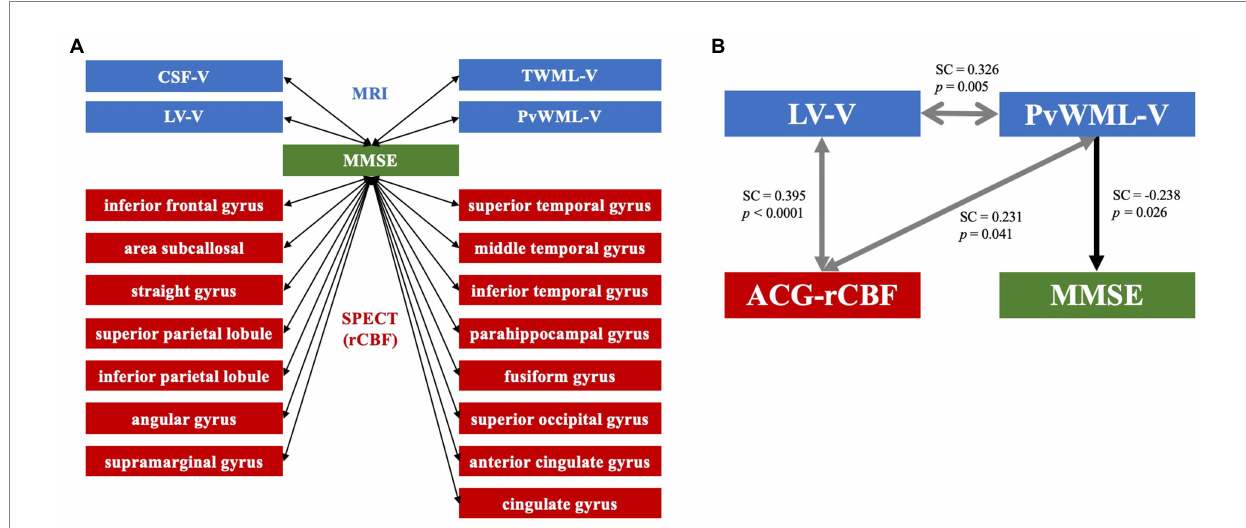
FIGURE 3 (A) MRI and SPECT data showing correlations with MMSE in early-stage cognitive impairment. The LV-V, CSF-V, TWML-V, and PvWML-V from MRI voxel-based morphometry analysis showed significant correlations with MMSE scores. The percentage of pixels with decreased rCBF ( Z -score > 2) in the regions shown in the figure correlated with MMSE scores in the SPECT 3D-SSP analysis. The arrows in both directions indicate correlation. (B) Path diagram. Path analysis suggested that there were interrelationships between the LV-V, PvWML-V, and ACG-rCBF, and that the PvWML-V directly affected the MMSE score. Arrows in both directions indicate interrelationships between factors, while unidirectional arrows indicate influence in that direction. MRI, magnetic resonance imaging; SPECT, single-photon emission computed tomography; MMSE, Mini-Mental State Examination; CSF-V, cerebrospinal fluid volume; TWML-V, total white matter lesion volume; LV-V, lateral ventricular volume; PvWML-V, periventricular white matter lesion volume; rCBF, regional cerebral blood flow; SC, standardized coefficient; ACG-rCBF, regional cerebral blood flow in the anterior cingulate gyrus; and 3D-SSP, 3D stereotactic surface